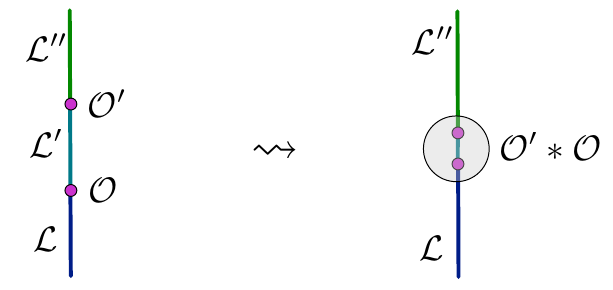
Figure 1 . Local operators at junctions of lines have products induced by